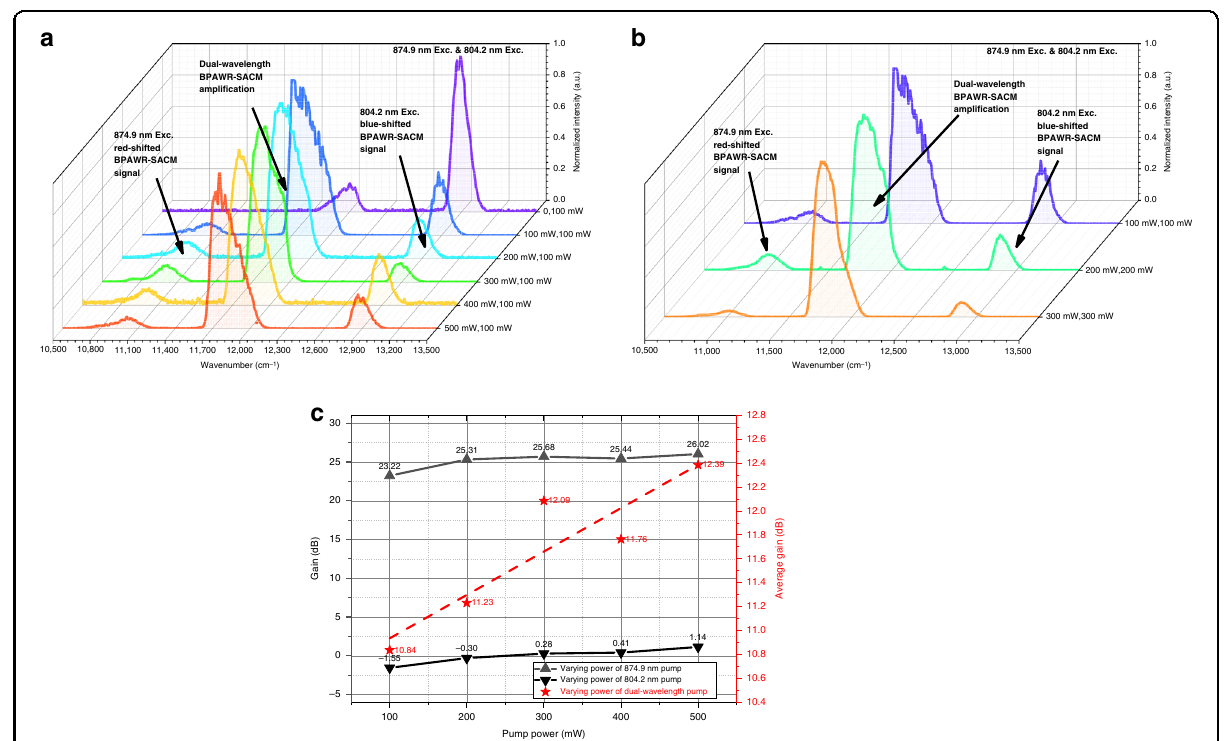
Fig. 4 Signal ampli fi cation by the dual-wavelength pump. a Normalized emission spectra were obtained by maintaining the laser power at 804.2nm constant and varying the laser ’ s power at 874.9nm alone. b Normalized emission spectra were obtained by keeping the dual-wavelength pump power at the same level. c The signal gain versus pump power. The gain was calculated from the ampli fi cation produced by keeping one laser power constant while increasing another alone. Average gain was calculated from the ampli fi cation produced by synchronously increasing the dual- wavelength pump